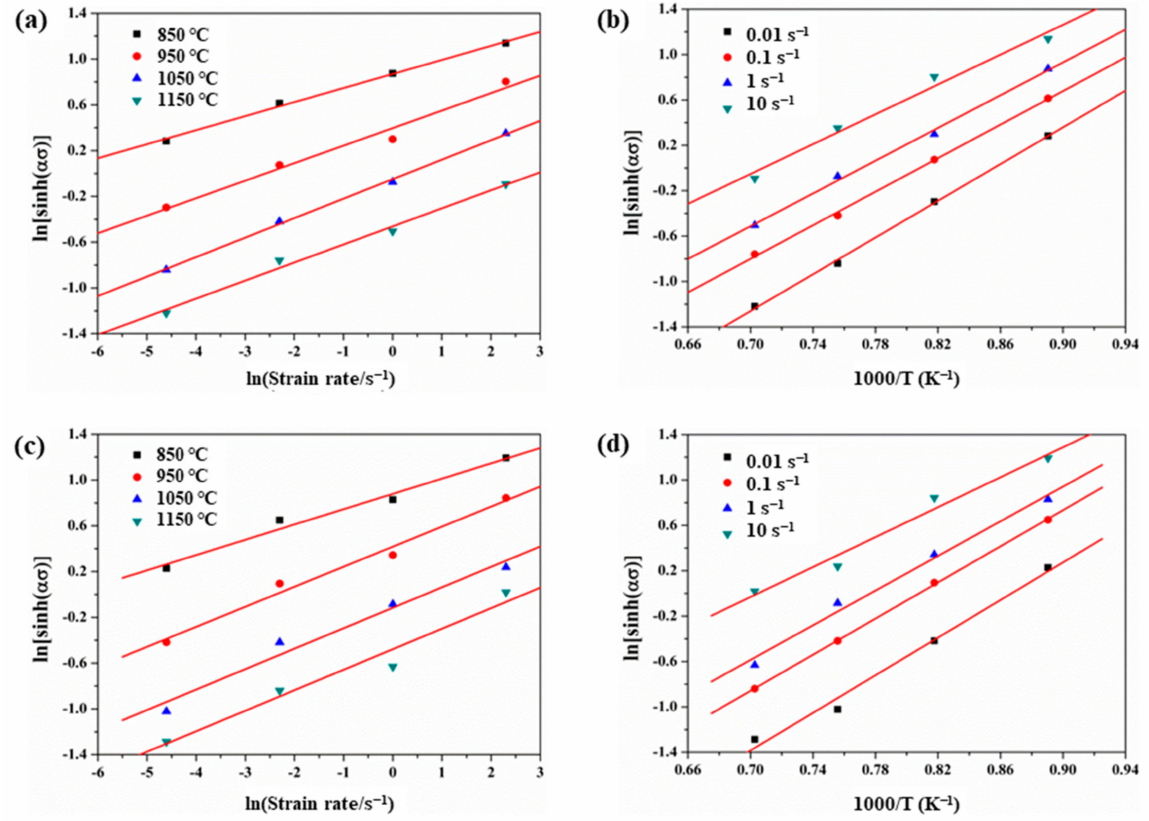
Figure 5. Relationship between peak stress and strain rate of 35CrMo steel during high temperature plastic deformation: ( a , b ) without ultrasonic, ( c , d ) with